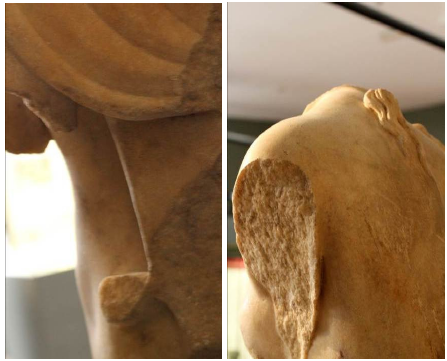
Figure 6 Images of two statues very close to a wall, taken with an ASP-C camera equipped with a 50mm lens.